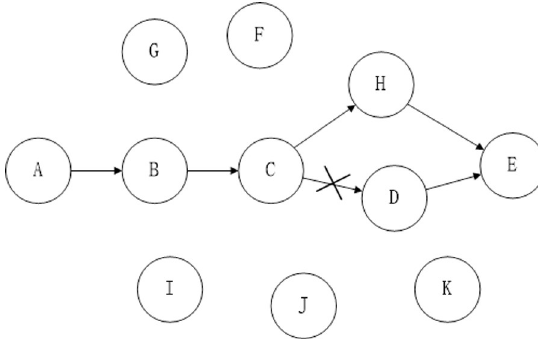
Fig 2. Example diagram of routing detection and